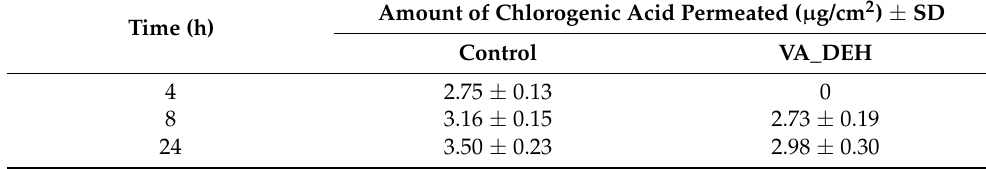
Table 7. Amount of chlorogenic acid permeated in ex vivo skin permeation